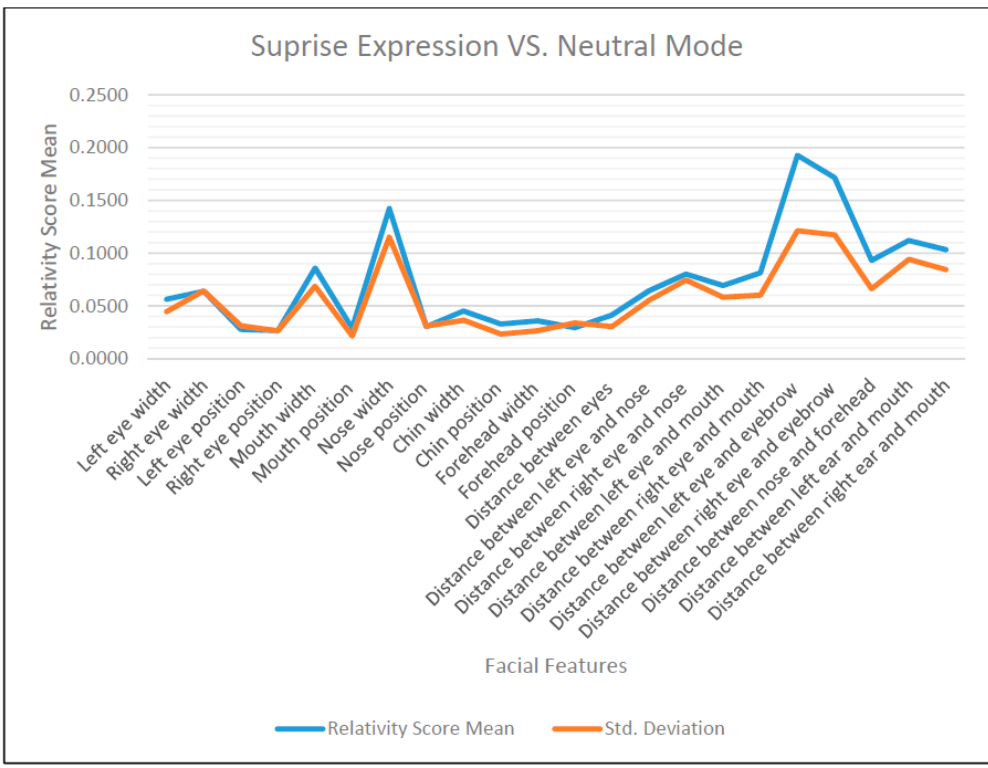
Figure 16. The means of RSS between surprise expression and neutral mode of facial features for 36 subjects.